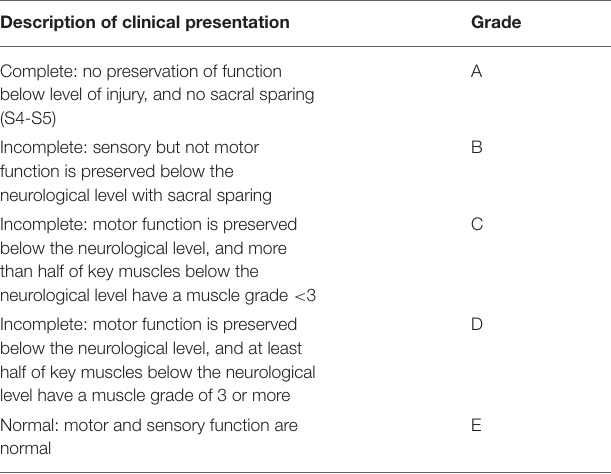
TABLE 1 | The American Spinal Injury Association (ASIA) scoring system. Description of clinical